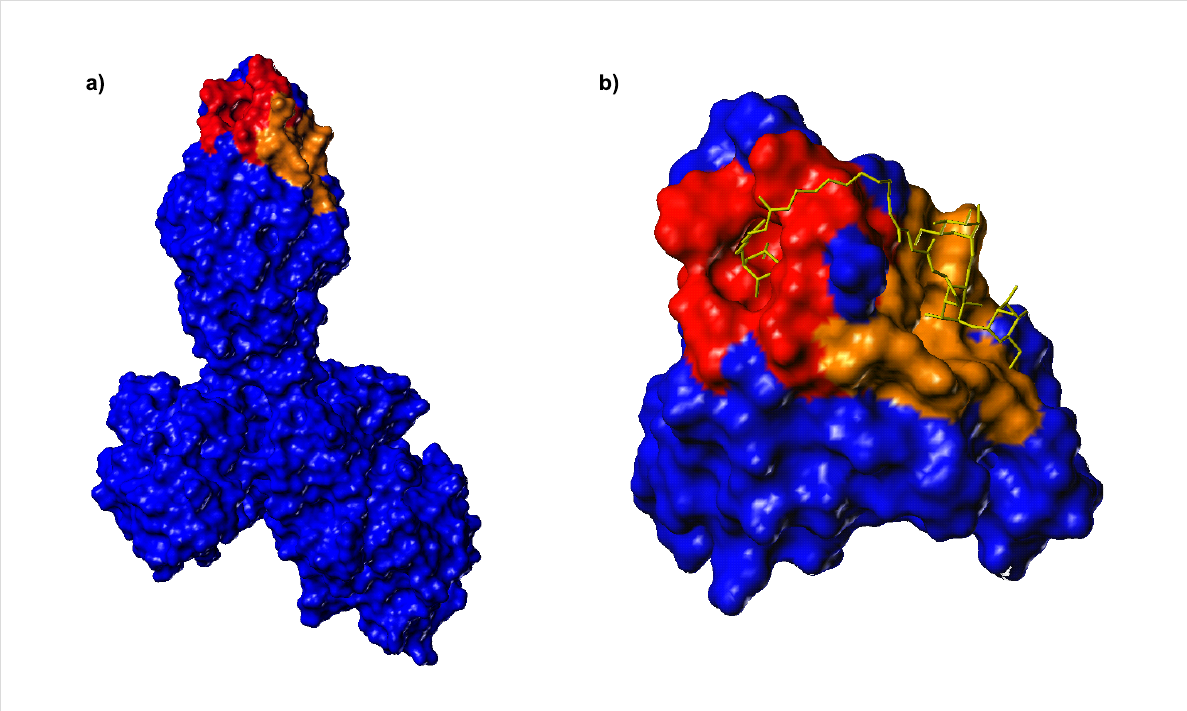
Figure 1: a) Connolly surface of FimH in complex with FimC [8]. The CRD known from X-ray structures at the tip of FimH is coloured in red and can accommodate one α -D-mannosyl residue. A second hypothetical carbohydrate binding region on the protein, as suggested by modeling studies [16], is coloured in brown and represents a more extended area on the protein. b) Docking studies were used to estimate the length of a linker that is required to bridge the putative two binding